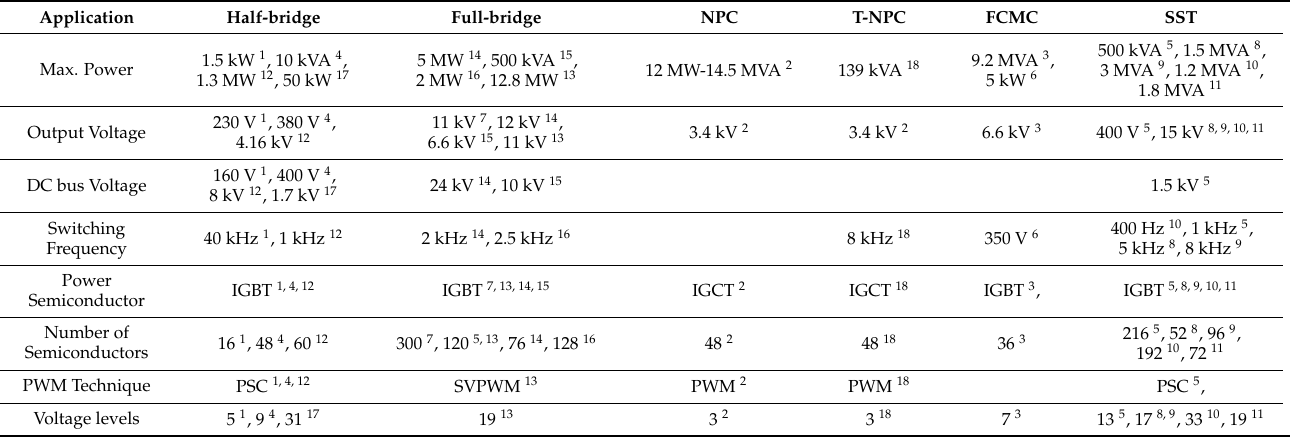
Table 3. Examples of MLC solutions and prototypes